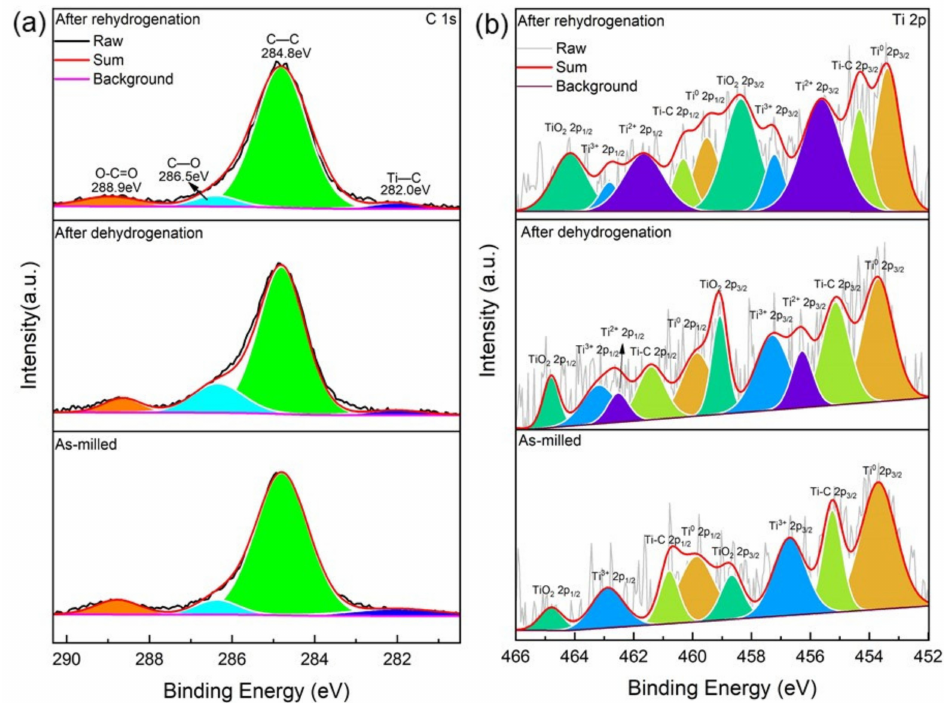
Figure 6. X-ray photoelectron spectroscopy (XPS) spectra of C 1s ( a ) and Ti 2p ( b ) of the as-milled, dehydrogenative, and rehydrogenative MgH 2 -6 wt.% ML-Ti 3 C 2